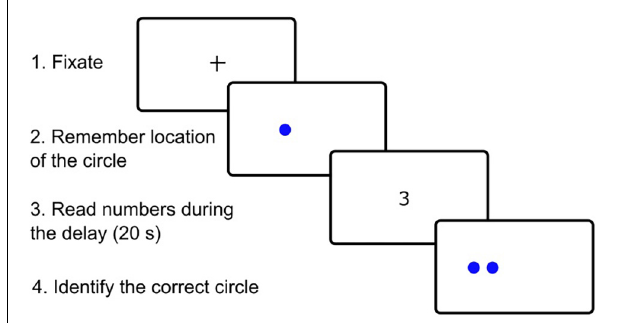
FIGURE 1 | Example of spatial pattern separation task in one of 32 trials as seen by participants on the computer screen.